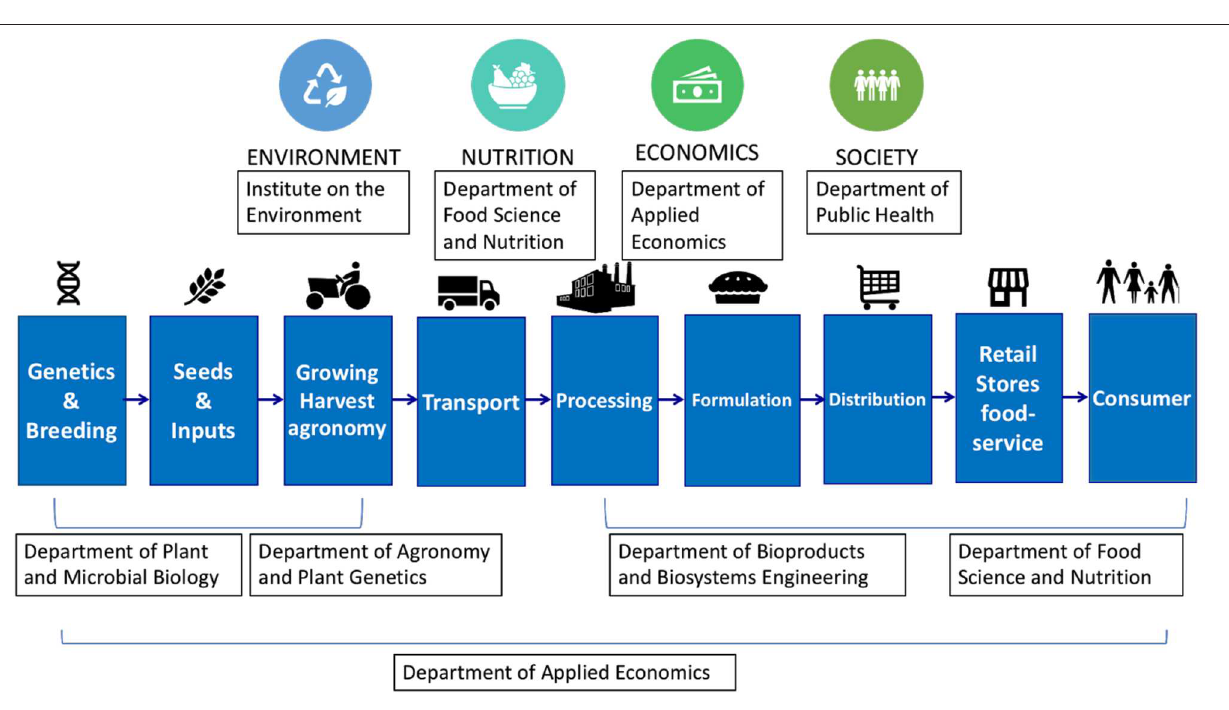
FIGURE 3 | University of Minnesota departments in relation to the value chain shows how several University of Minnesota departments could interact with the value